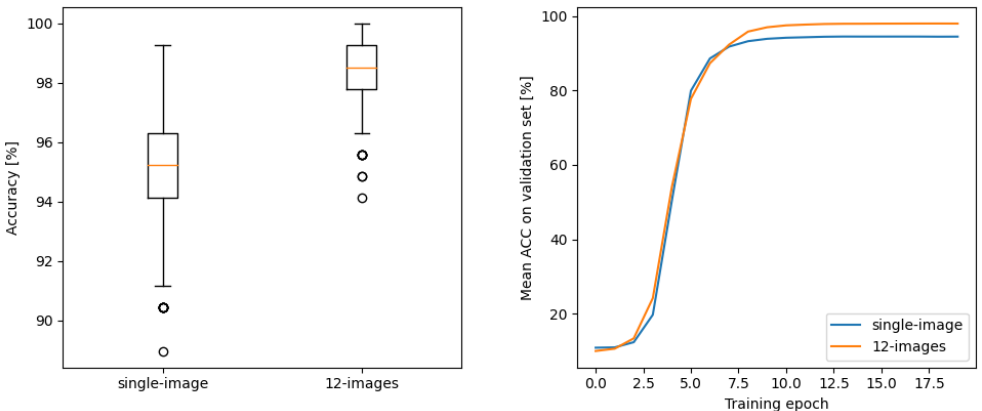
Figure 8. Accuracy results from experiments with ResNET classifier. On the left: spread of accuracy for 500 models trained either with a single- or multiple-image input; on the right: the average accuracy achieved by models across the training